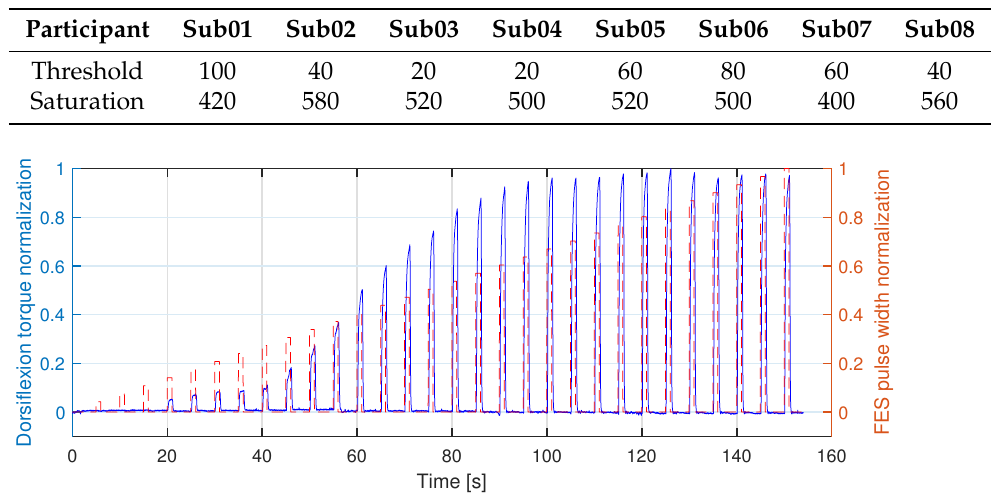
Table 1. FES pulse width threshold and saturation values from each participant (Unit: µ s)